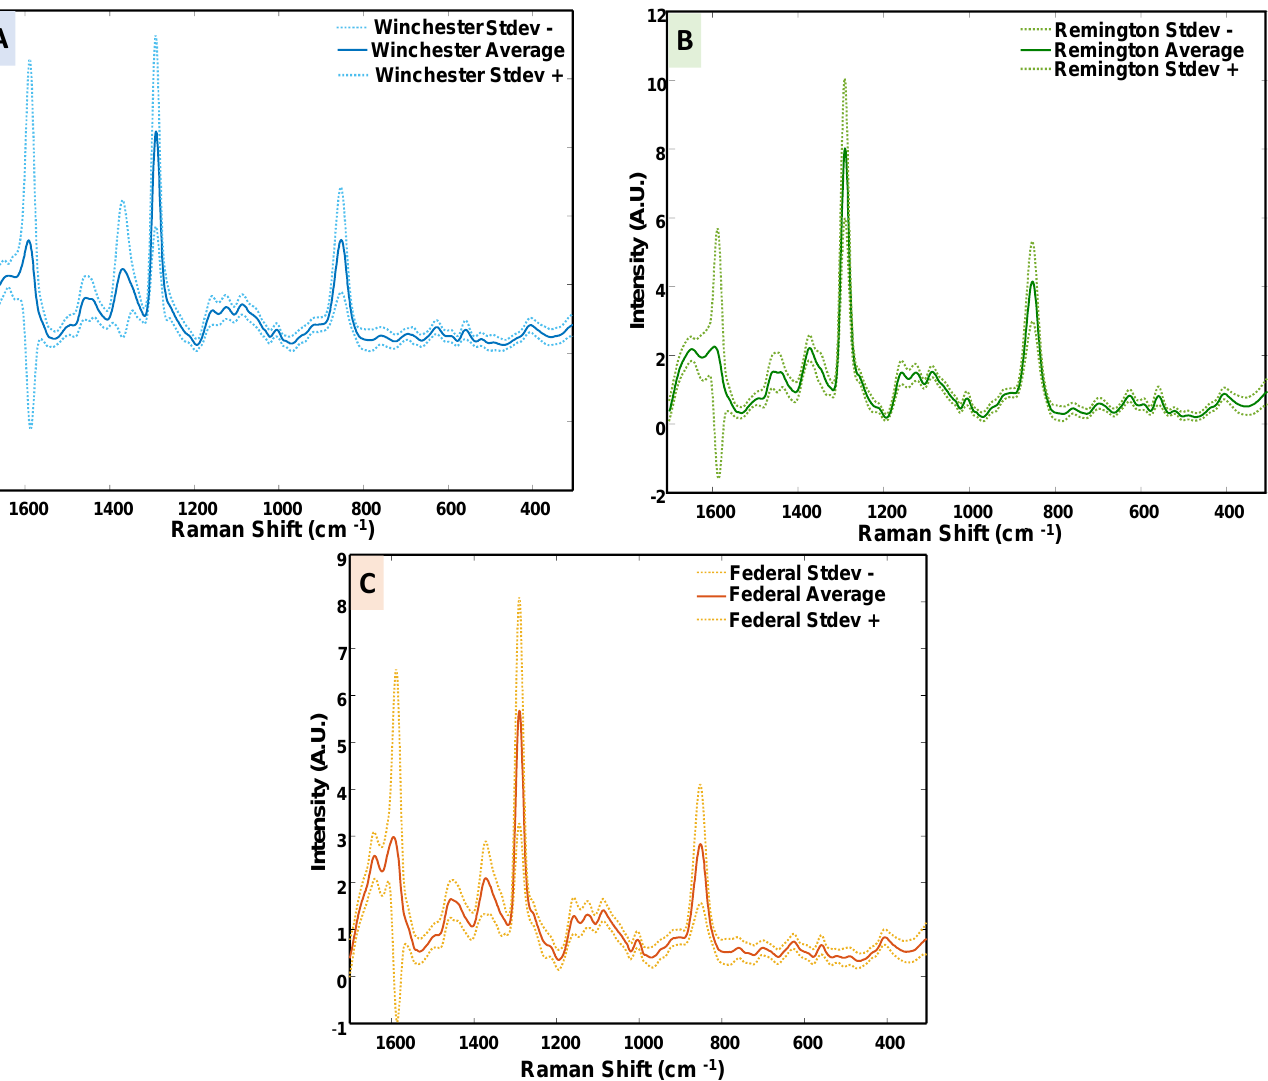
Figure 3. Average and standard deviation Raman spectra for the three sample classes. Solid lines indicate the average spectra while dotted lines indicate the standard deviation spectra. Labels indicate: ( A ) Winchester, ( B ) Remington, and ( C ) Federal datasets.